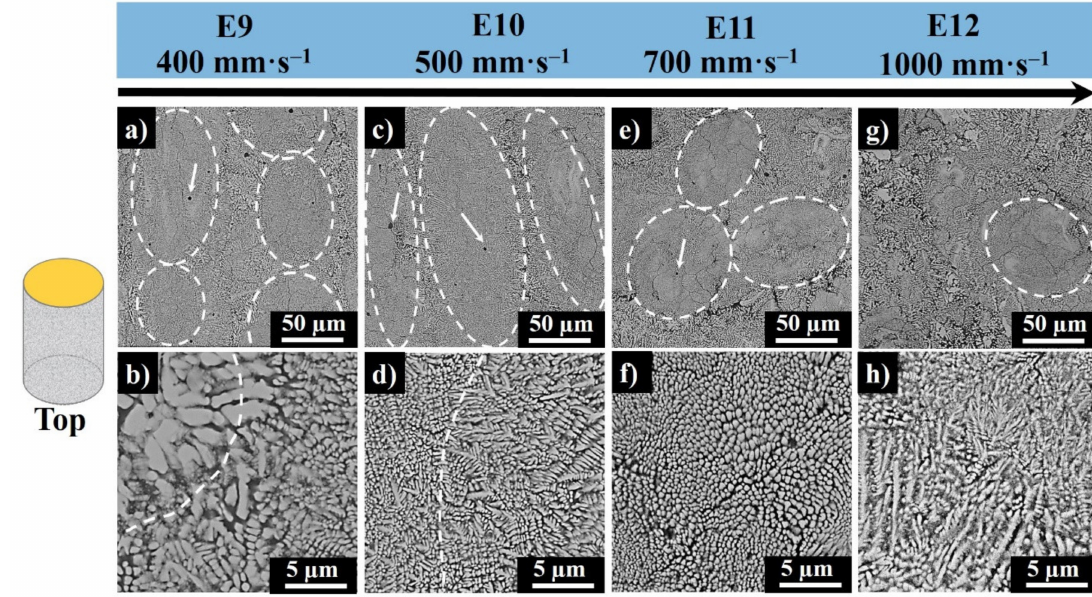
Figure 9. Top surface SEM images of E9 ( a , b ), E10 ( c , d ), E11 ( e , f ), and E12 ( g , h ) produced at 200W laser powers and at 400 mm · s − 1 , 500 mm · s − 1 , 700 mm · s − 1 , and 1000 mm · s − 1 scanning speed, respectively (white dashed ovals represent melt pool cores, the white arrow points the precipitates of Al–Si rich phase, white dashes in b and d highlight the morphology transition